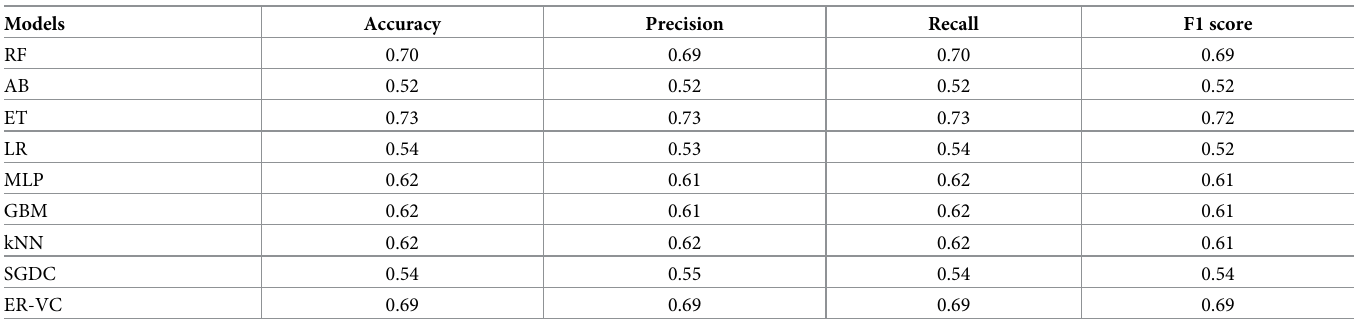
Table 11. Classification results of machine learning models using GloVe with ADASYN.